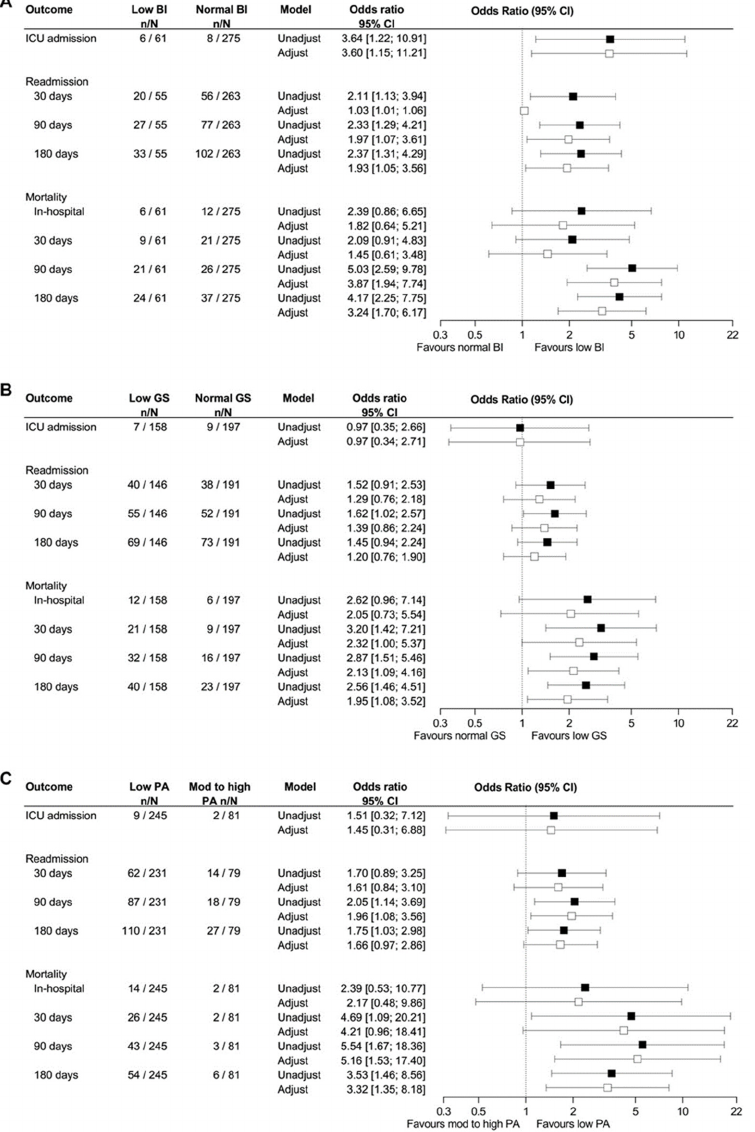
Figure 2. Association between low Barthel index ( A ), low grip strength ( B ), and low physical activity level ( C ) and prognosis among 355 patients admitted with community-acquired pneumonia. The association between low Barthel index, low grip strength, and low physical activity (PA) level and risk for admission to the intensive care unit (ICU), readmission, and mortality were analyzed in an unadjusted logistic regression model (black) and a logistic regression model adjusted for age (white). The patients who died in the hospital are not included in the analyses for readmission. Low grip strength: <27 kg for males and <16 kg for females. Low physical activity level: <600 MET-min/week vs. moderate (Mod) to high physical activity level: ≥ 600 MET-min/week. Low Barthel index <80.